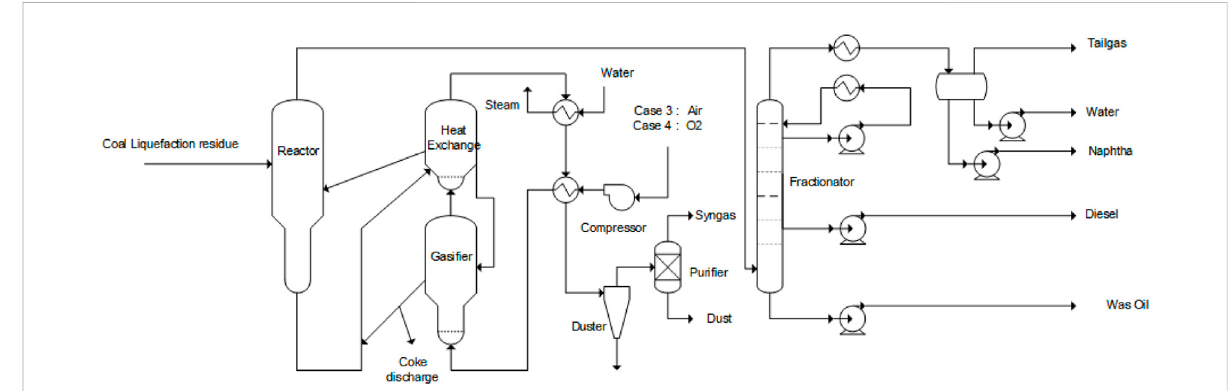
FIGURE 3 Flexible fl uidized pyrolysis (case 3: fl exible fl uidized pyrolysis air gasi fi cation; case 4 fl exible fl uidized pyrolysis oxygen gasi fi